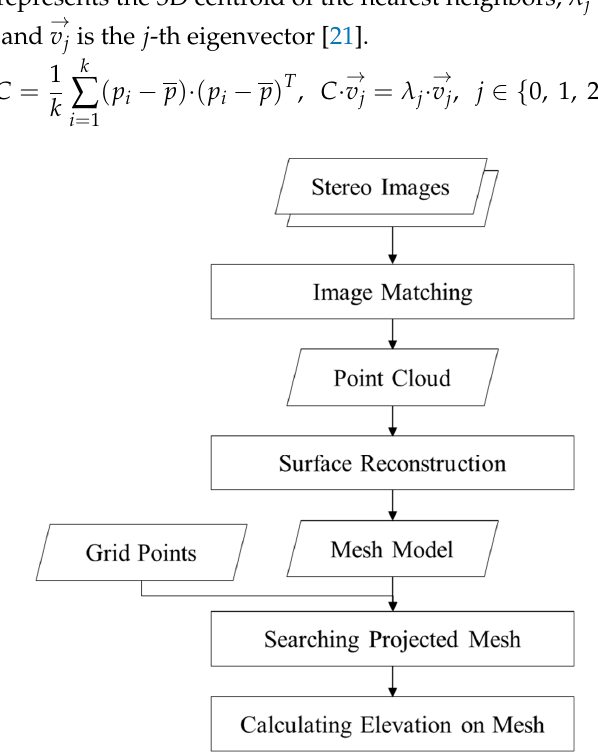
Figure 1. Workflow for generating a mesh-based digital surface model (DSM).